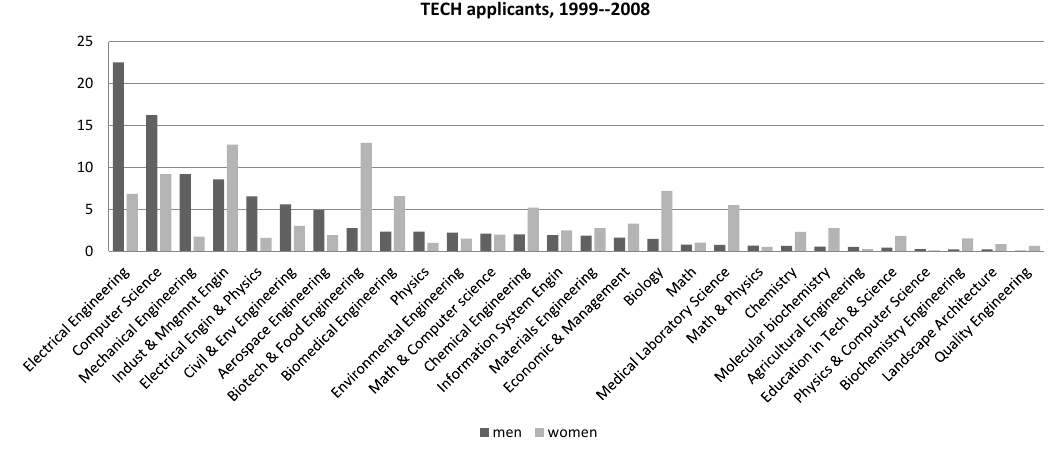
Figure 2: The Distribution of First-choice Majors, by Gender,